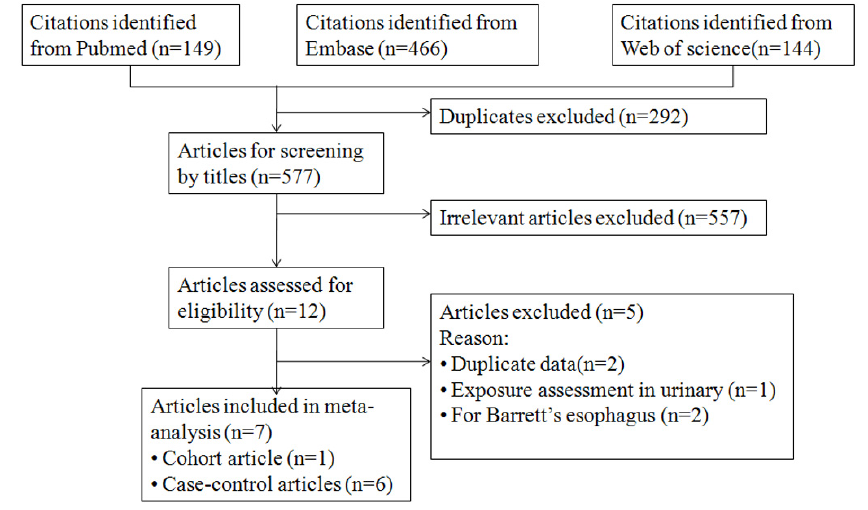
Figure 1. A flow diagram for selection of studies and specific reasons for exclusion from this meta ‐ analysis.